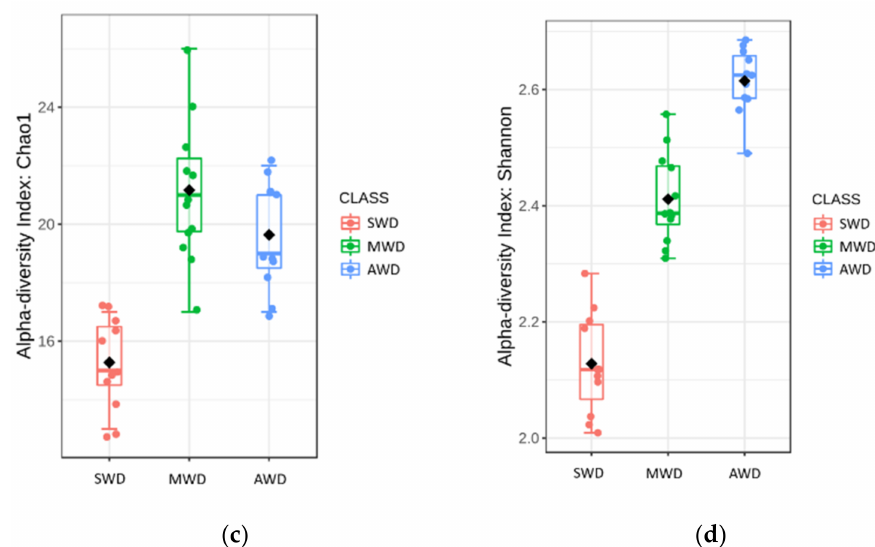
Figure 2. Boxplot illustrating the differences in ( a ) Chao1 and ( b ) Shannon diversity measures at the 6-month sampling time and ( c ) Chao1 and ( d ) Shannon diversity measures at the 12-month sampling time of the fungal communities in the root, at dif-ferent irrigation regimes: severe water deficit (SWD), moderate water deficit (MWD), and absence of water deficit (AWD).